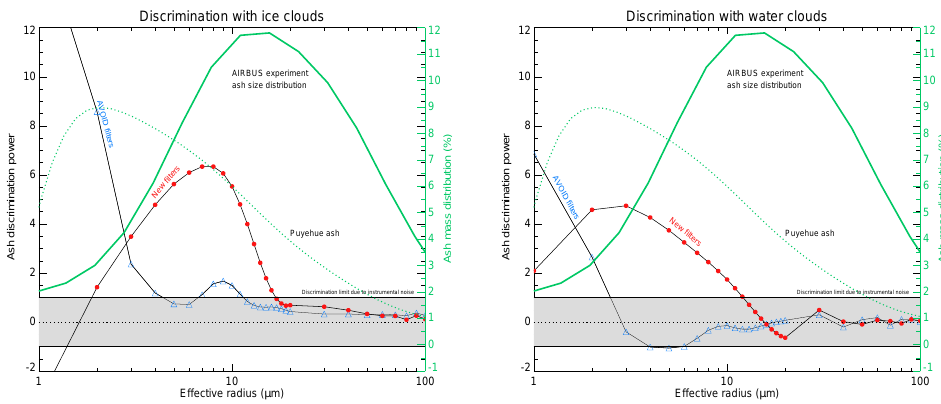
Figure 8. Discriminating power as a function of effective radius for two different pairs of filters when the interfering substance is ice (left-hand side), and when the interfering substance is water (right-hand side). The black lines show the current sub-optimal standard filters (used in the AIRBUS experimemt) and the red-coloured lines show a new pair of filters selected using radiative transfer simulations. Also shown are size distributions for ash used in the AIRBUS experiment and for a sample from the recent Puyehue eruption in Chile.